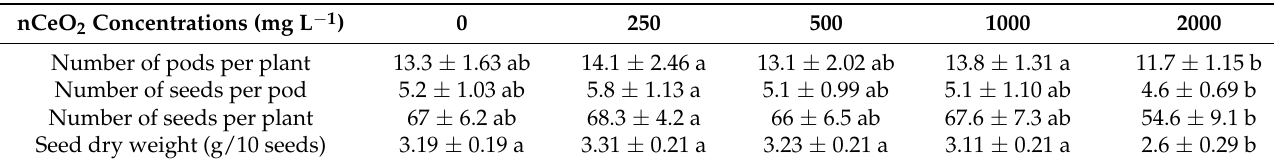
Table 1. The number of pods per plant, seeds per pod, seeds per plant, and seed dry weight in seeds harvested from control and nCeO 2 -treated plants. Values are expressed as mean ± SE. Different letters represent a significant difference between